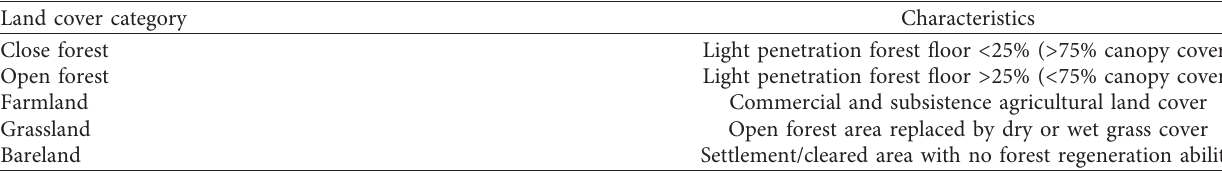
Table 2: Definitions of land cover categories [29,